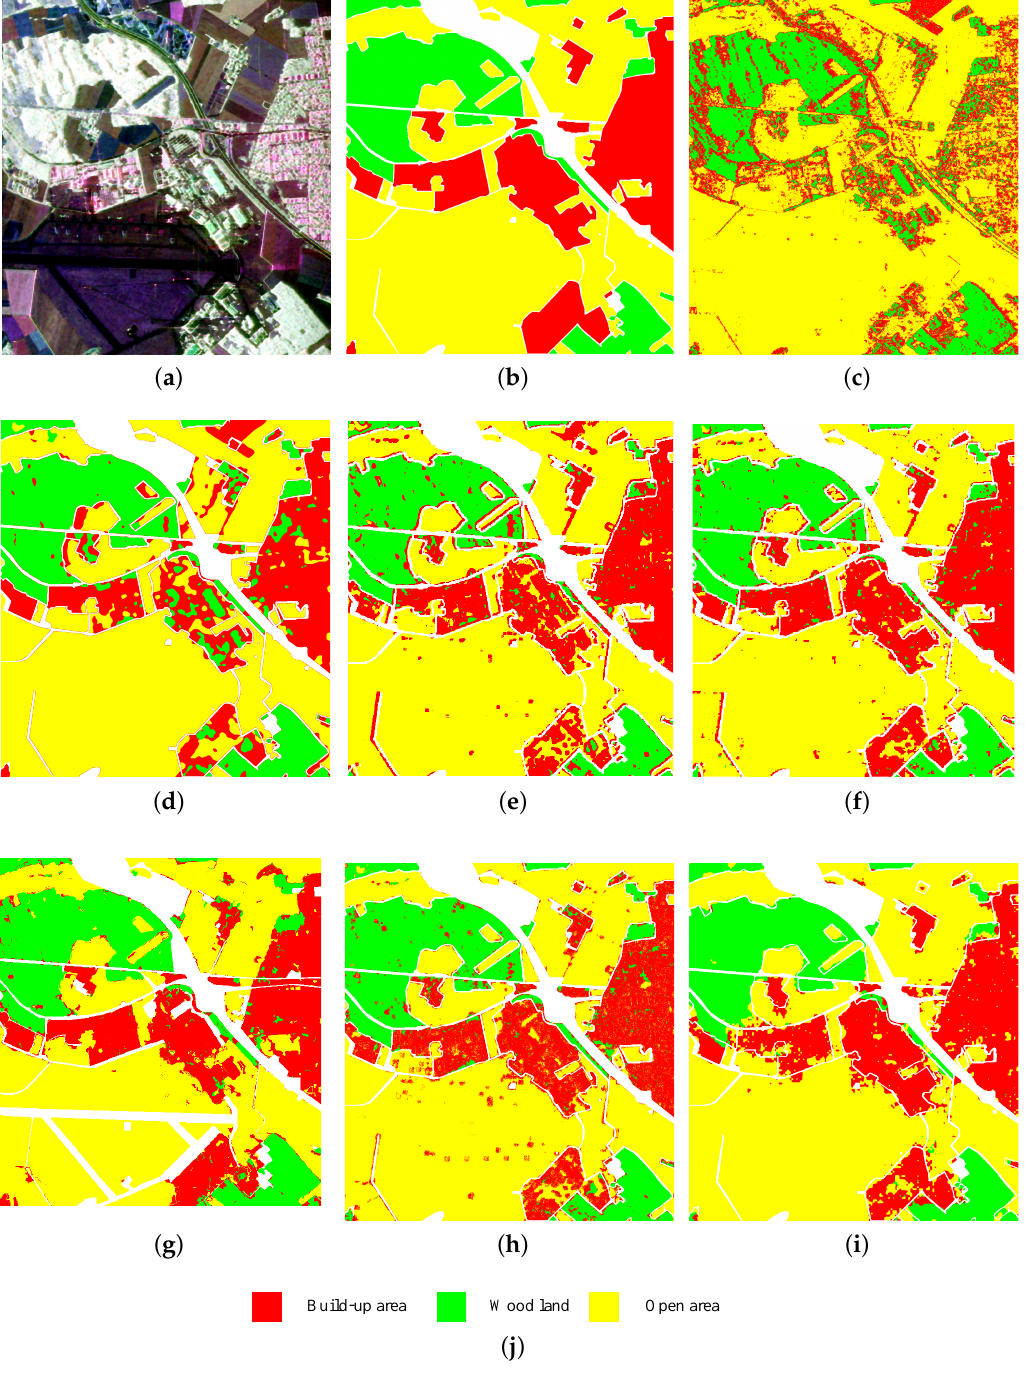
compared on this dataset are the SVM [29], RS [21], and CNN-based RV-CNN [32] and CV-CNN [51] methods, and the SRDNN method [52].